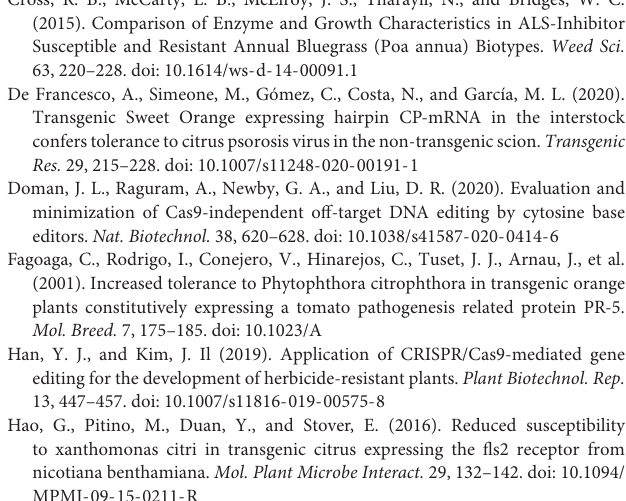
Supplementary Figure 4 | Identification of T-DNA-free regenerants using three primer pairs. (A) Schematic representation of the T-DNA used for Agrobacterium tumefaciens transformation experiments. Regions amplified by the different pairs of primers are marked by red lines: PCR1 (35S finalF, B596), PCR2 (B595, B600), and PCR3 (B421, B422). Primer sequences are detailed in Supplementary Table 2 . (B) Representative results of PCR analysis from 192 regenerant